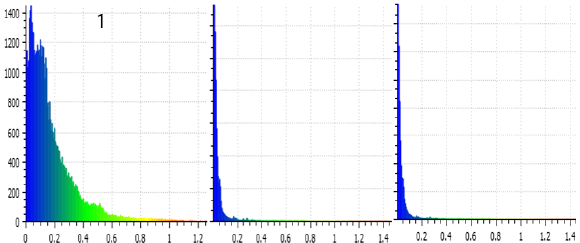
Figure 10. Point-to-Point distance histogram for data: (1) before registration (2) after registration (noisy data) (3) after registration (clear